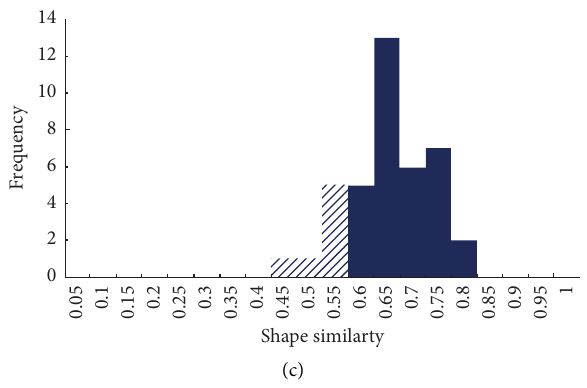
Figure 7: Results of shape similarity for each frequency: (a) 200-year; (b) 150-year; (c) Table 4: Overall results of the SIND model.